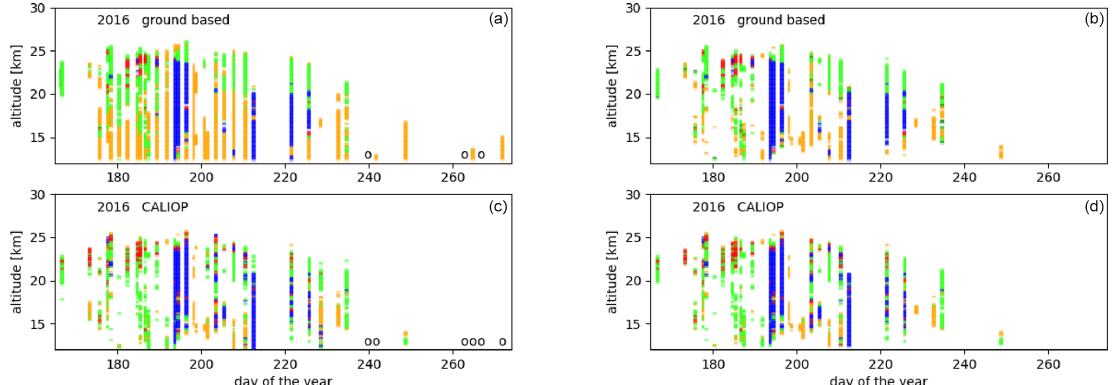
Figure 5. All quasi-coincident observations (a, c) and only those where PSCs were observed by both lidars (b, d) for 2016 above Dome C. (a, b) Ground-based lidar. (c, d) CALIOP above Dome C. The different colors indicate PSCs of different composition. Green: NAT mixtures; yellow: STS; red: enhanced NAT mixtures; blue: ice. The circles indicate measured profiles without